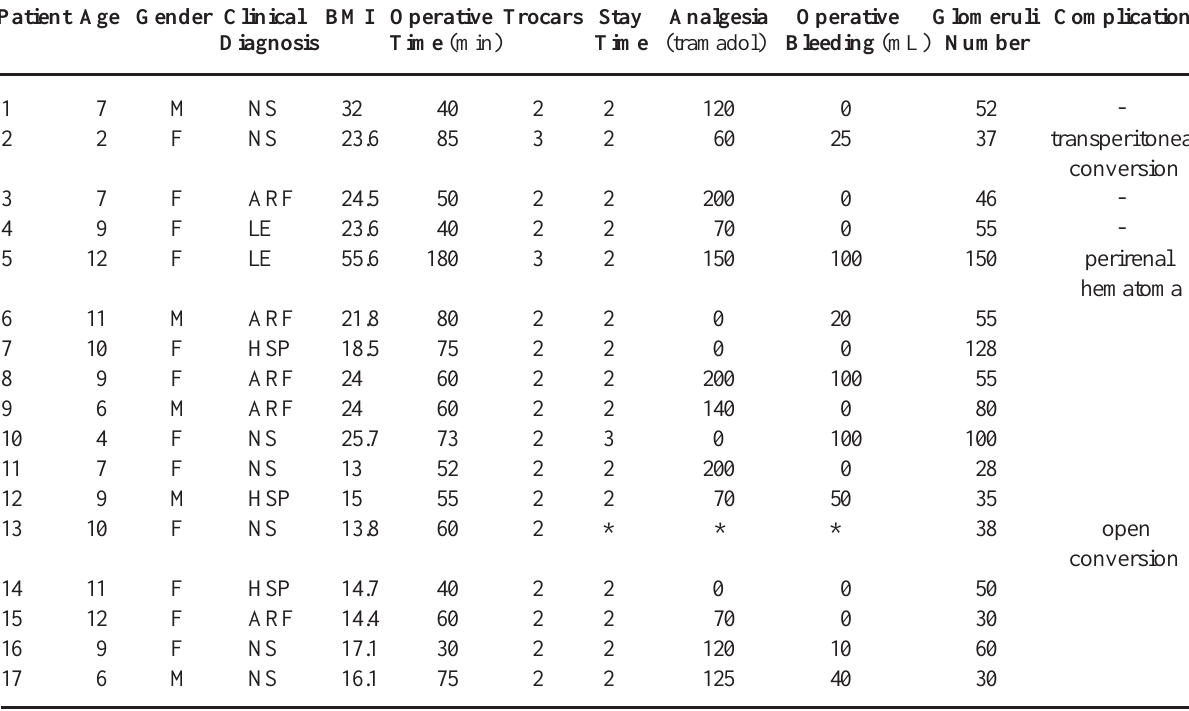
Table 1 – Clinical features of patients submitted to retroperitoneal renal biopsy. Time (tramadol) Bleeding (mL)